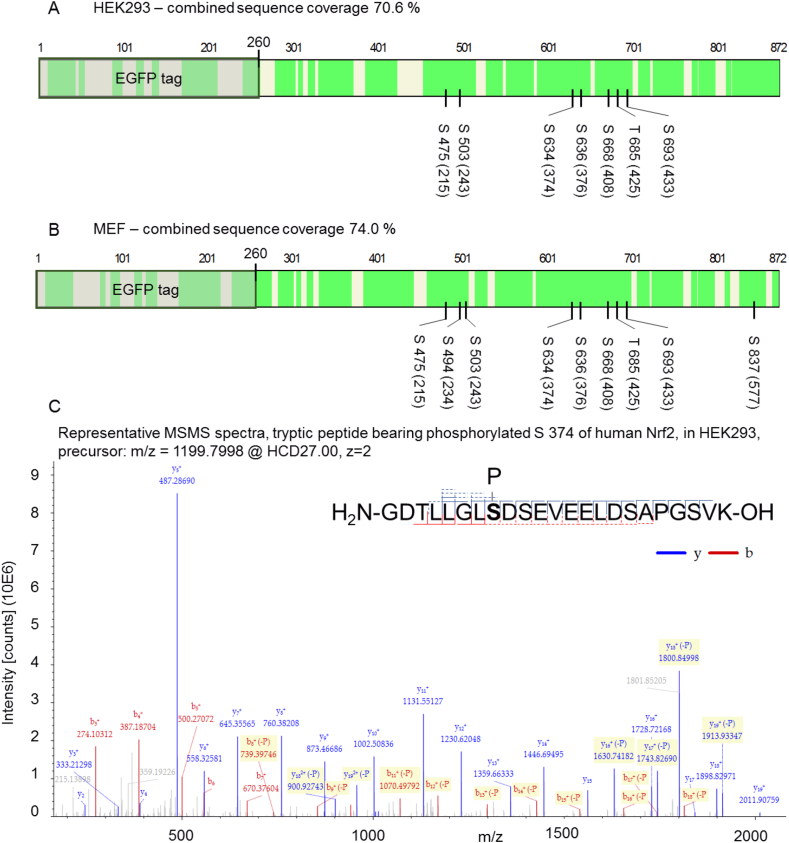
Identified phosphorylation sites in Nrf2 after immunoprecipitation from cell lysates and subsequent MS analysis. HEK293 (A) or MEF (wt) (B) were transiently transfected with an expression plasmid for human EGFP-WT-Nrf2 and treated with proteasome inhibitor (and AMPK activator) for 4 h. After cell lysis, Nrf2 was pulled down by a GFP-Trap and prepared for MS analysis as described in the method section. Covered sequence areas are marked in green and reproducibly found phosphorylation sites at S or T residues within the EGFP-WT-Nrf2 fusion protein are indicated (in brackets: corresponding position in native human Nrf2). (C) Representative example of a MS/MS spectra from a phospho-peptide, showing the resulting fragments (b and y series) after HCD fragmentation (27 NCE), at position 8 serine is phosphorylated. The b series is shown in red, the y series is shown in blue (dashed lines: fragments with modification loss, more than one line: found in different charge states as indicated in the spectra). (For interpretation of the references to colour in this figure legend, the reader is referred to the Web version of this article.)